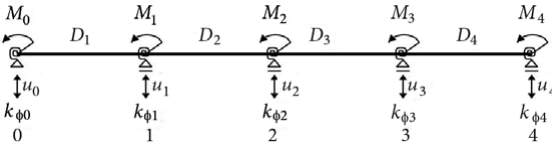
Fig. 10. Computational model of isolated rigid flange Table 2. Forces transferred from cross beams to analysed truss girder Cross beam number (Fig. 7)